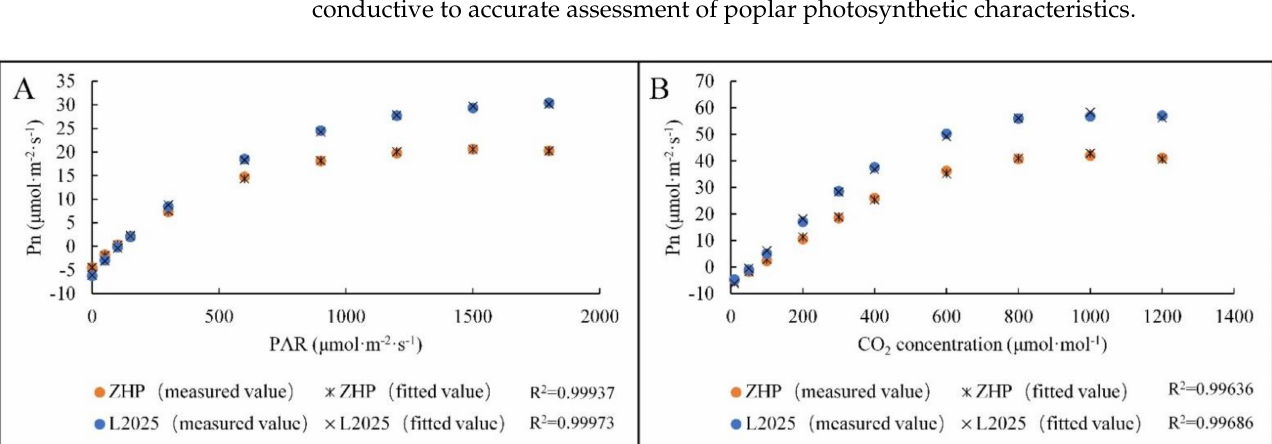
Table 2. Photosynthetic characteristic parameters of light response curves in ‘L2025’ and ‘ZHP’ seedling leaves.